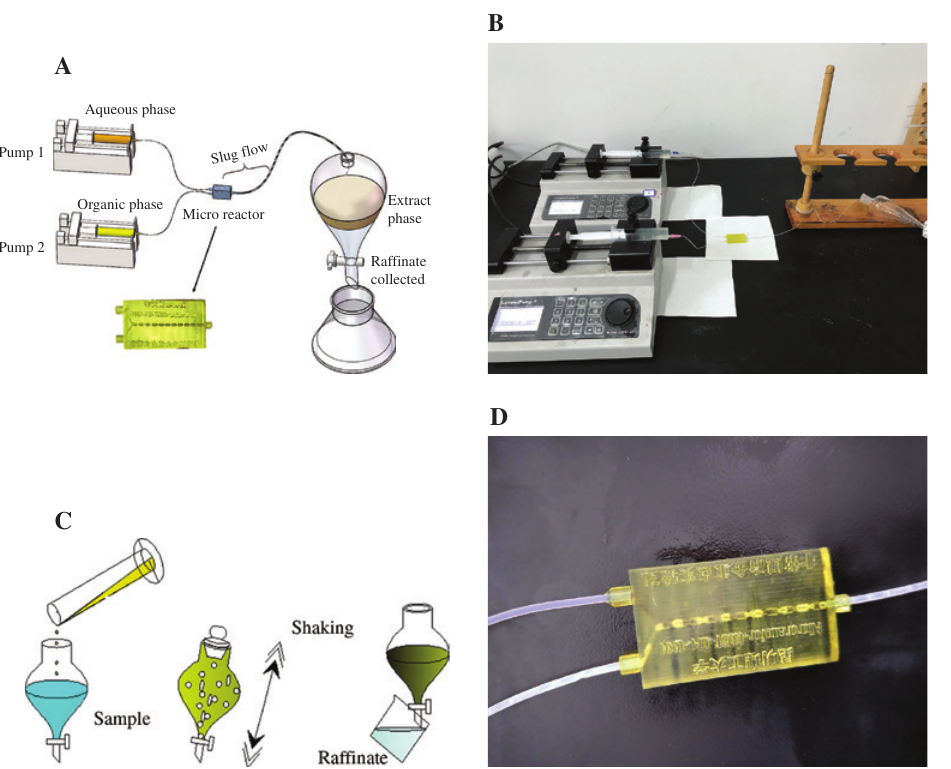
Figure 3: Flow diagram of extraction experiment: (A) schematic diagram of the process of extraction, (B) practical picture of the extraction experiment, (C) separating funnel shaking method to imitate conventional extraction in industrial devices, (D) flow details in the microreactor during